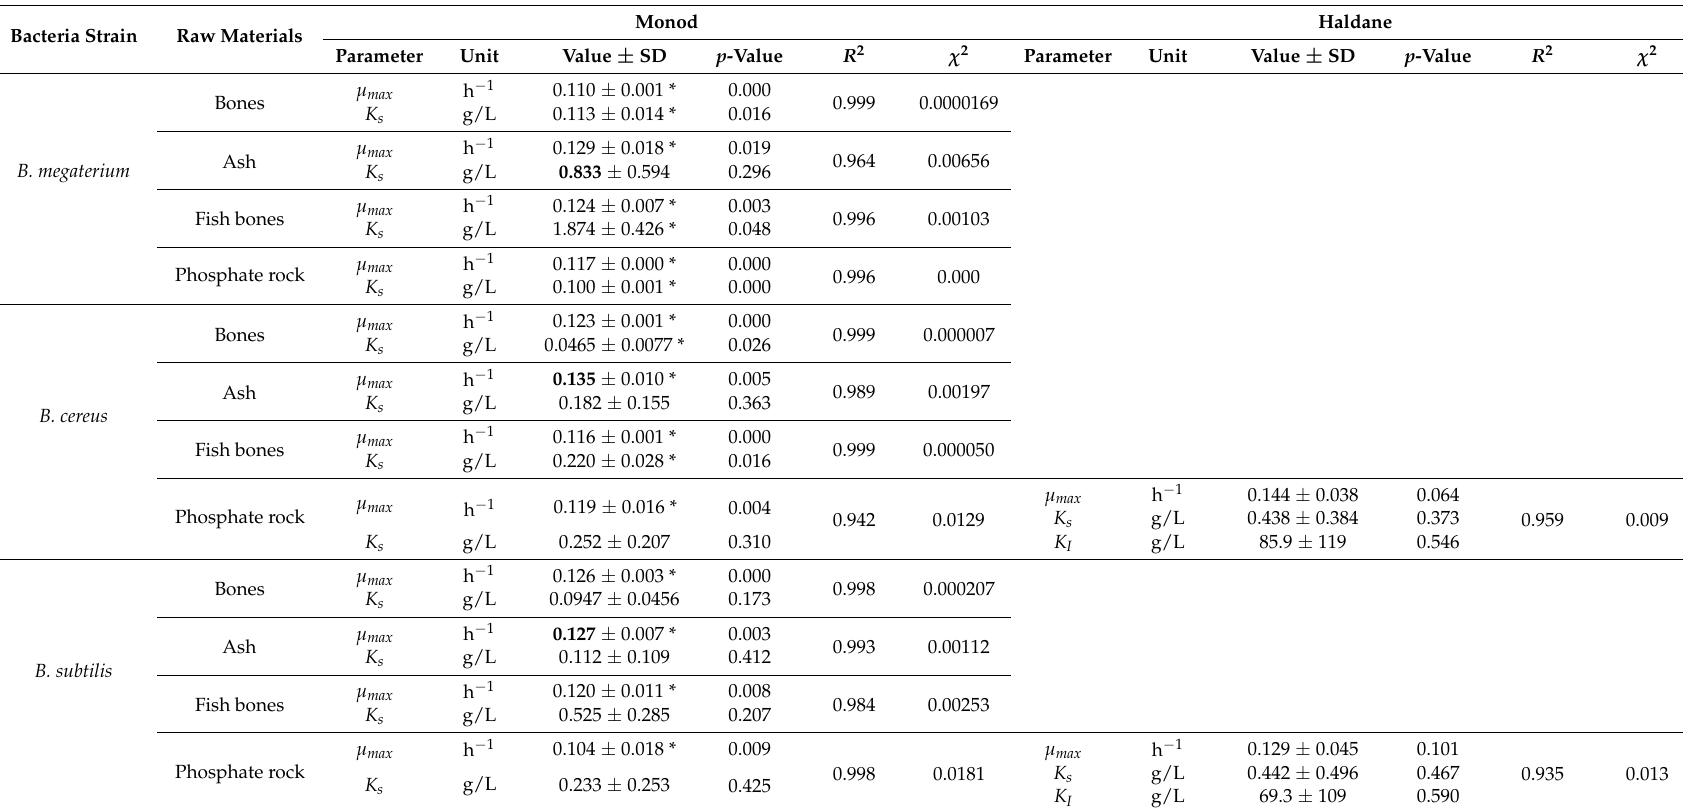
Table 1. Monod parameters of growth of Bacillus species under different